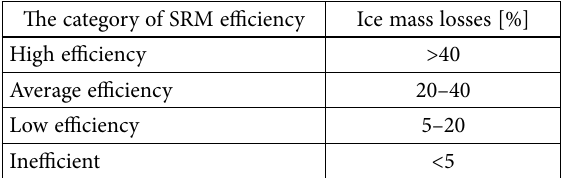
Table 4. Categories of ice melting intensity